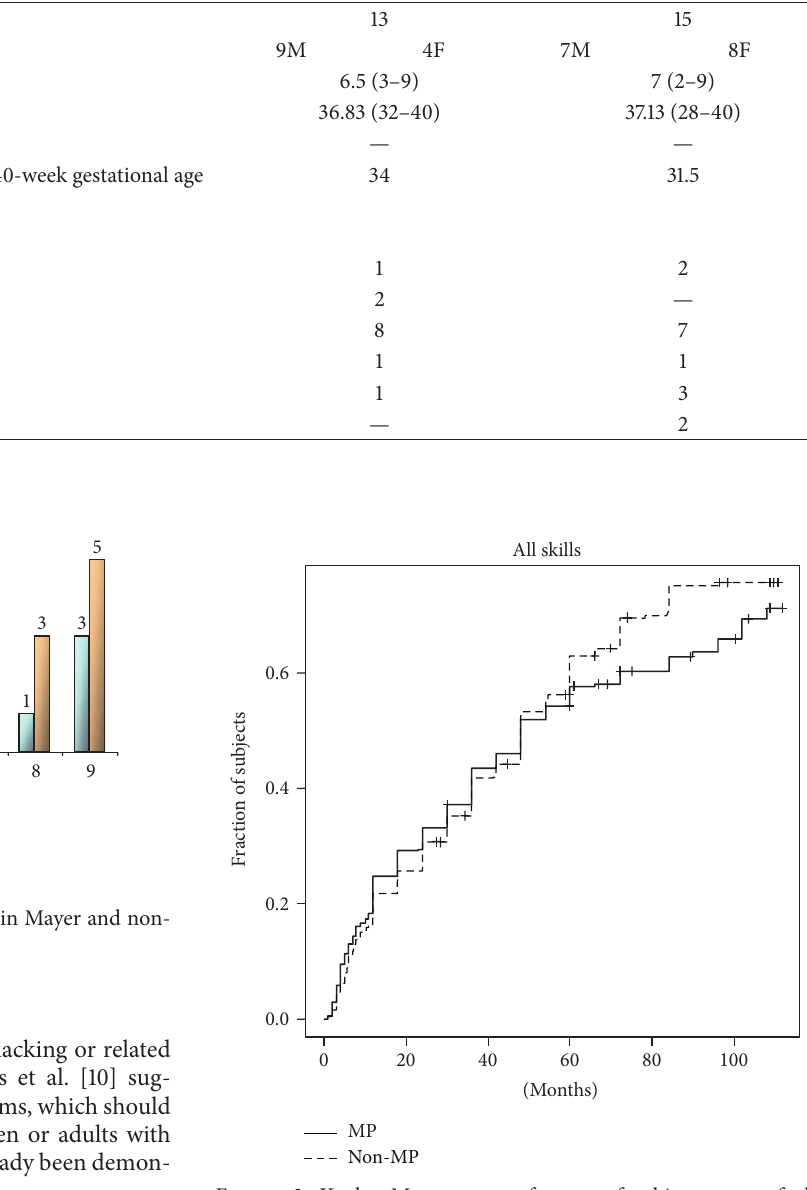
Figure 2: Kaplan-Meyer curves for age of achievements of all items included in the validated Italian translation for the Denver Developmental Screening Test I. MP: Mayer Project; non-MP: non- Mayer